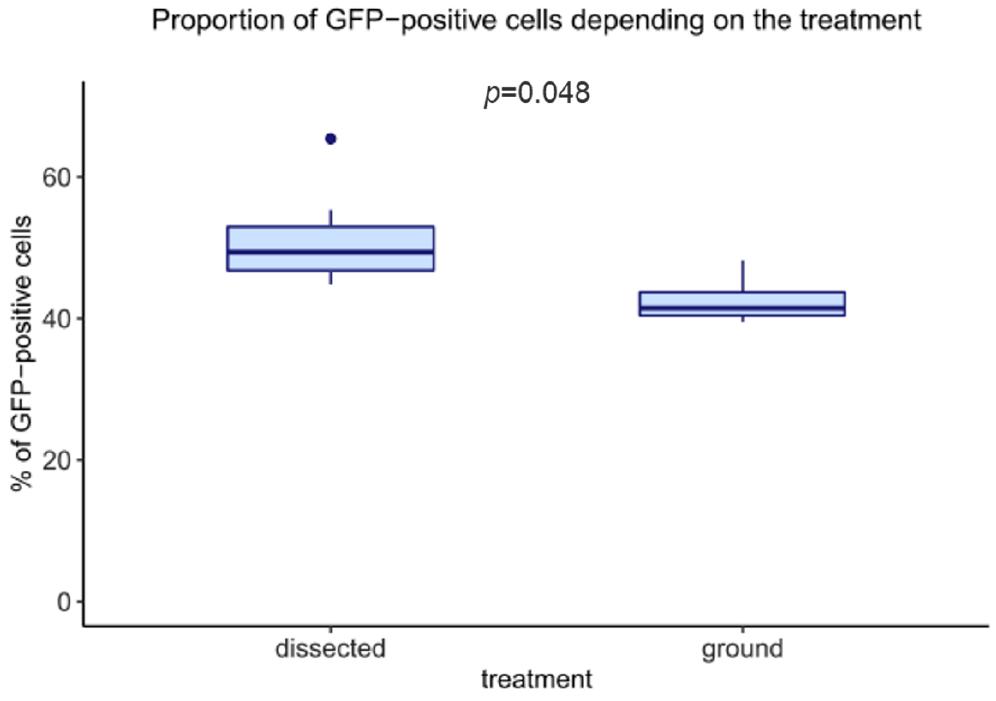
Figure 4. Proportion of GFP-positive cells in wing imaginal discs recovered by mass-enrichment protocol or dissection. vg > GFP expressing wing discs were recovered by either dissection or using our mass enrichment protocol, were dissociated, and the number of GFP-positive cells was measured by flow cytometry. A Wilcoxon test was performed for comparison ( n = 12).